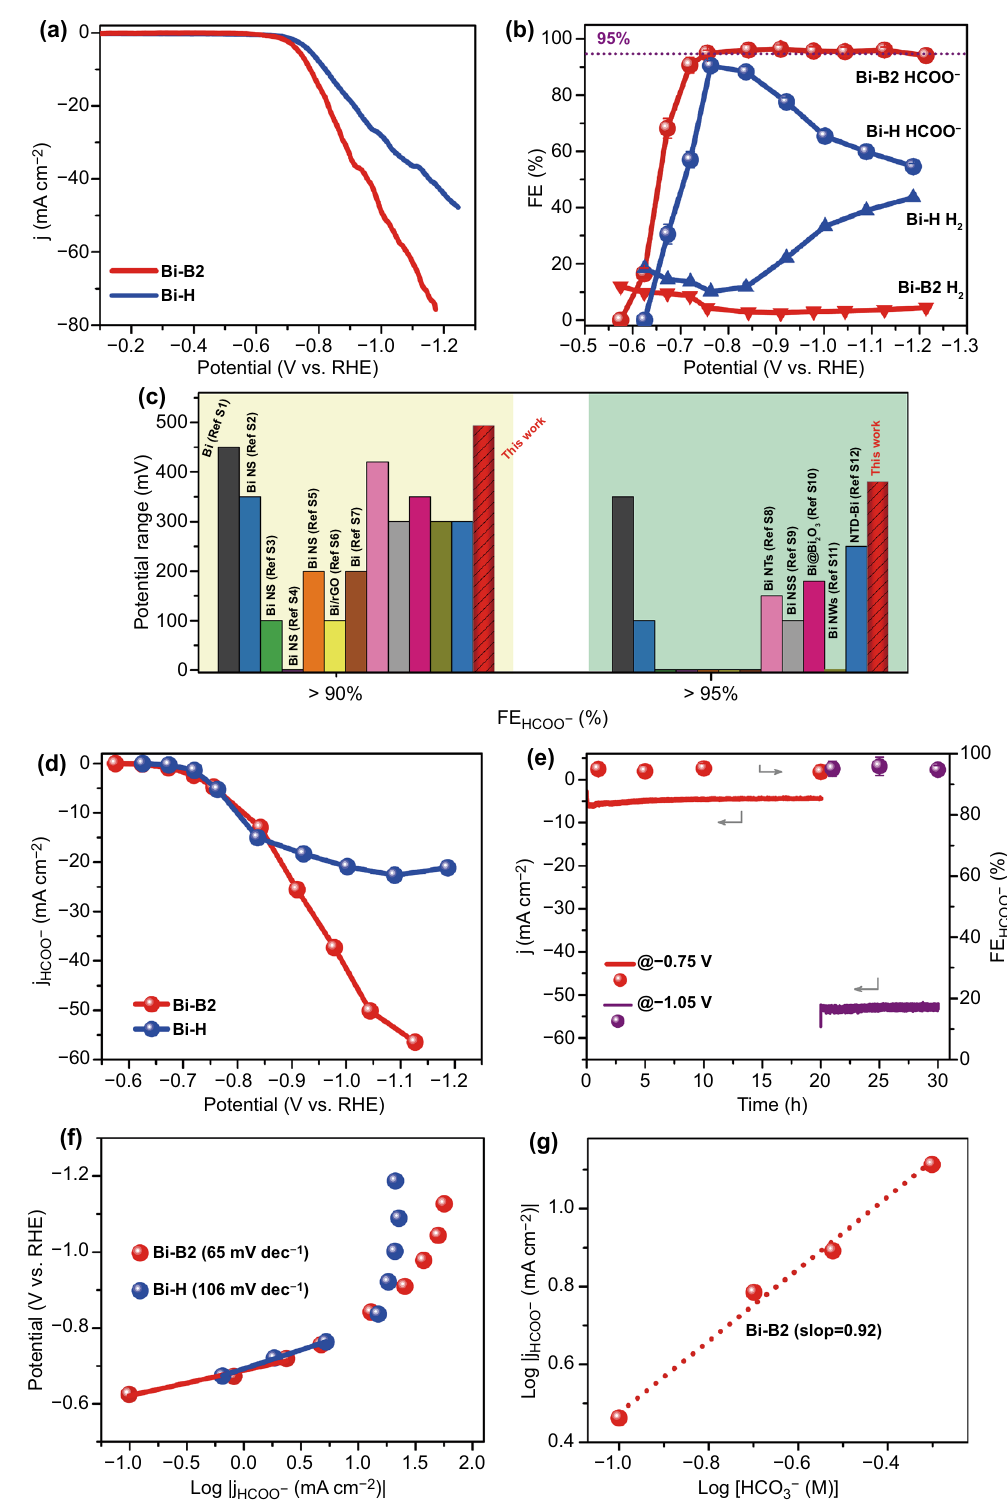
Fig. 3 a LSV curves in CO 2 saturated solution and b FEs of formate and H 2 for Bi‑B2 and Bi‑H, c comparison of the‑state‑of‑the‑art Bi‑based elec‑ trocatalysts with high formate FEs, d formate partial current density for Bi‑B2 and Bi‑H, e long‑term stability test at ‒ 0.75 V for 20 h and further at ‒ 1.05 V for 10 h for Bi‑B2, f Tafel slopes for Bi‑B2 and Bi‑H and g bicarbonate order dependence data at − 0.84 V for